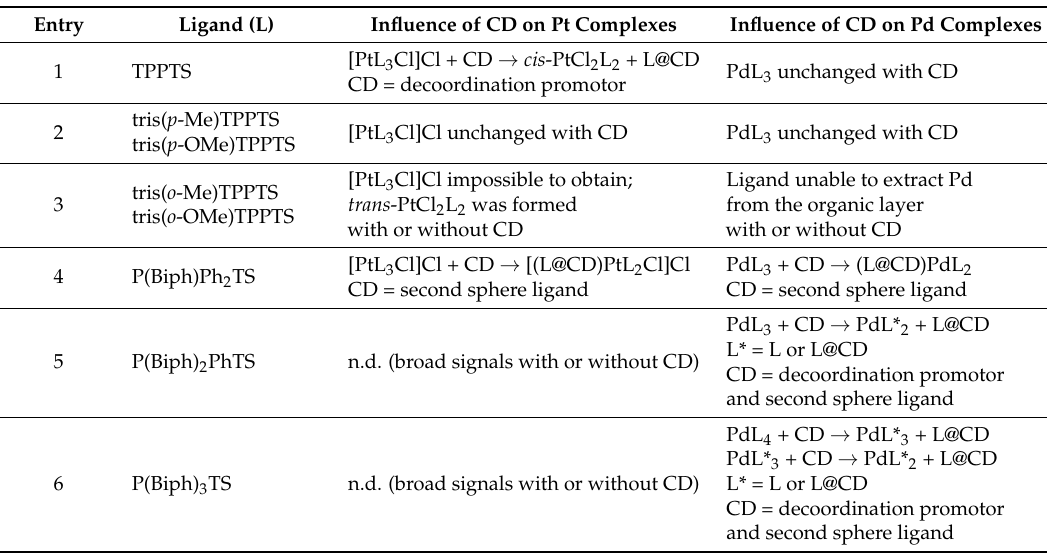
Table 4. Effects of RAME- β -CD addition on the platinum and palladium complexes obtained with the different phosphanes (in D 2 O, at 25 ◦ C); CD = RAME- β -CD; L@CD = Ligand included in the CD